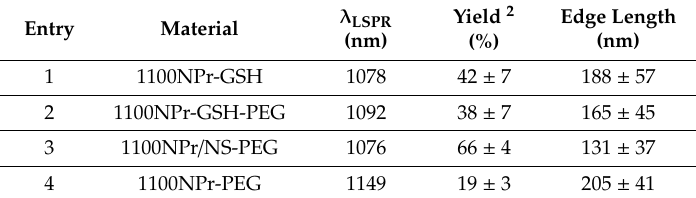
Table 1. Comparison of λ LSPR , yield, and size of the NPrs prepared by the two methods.